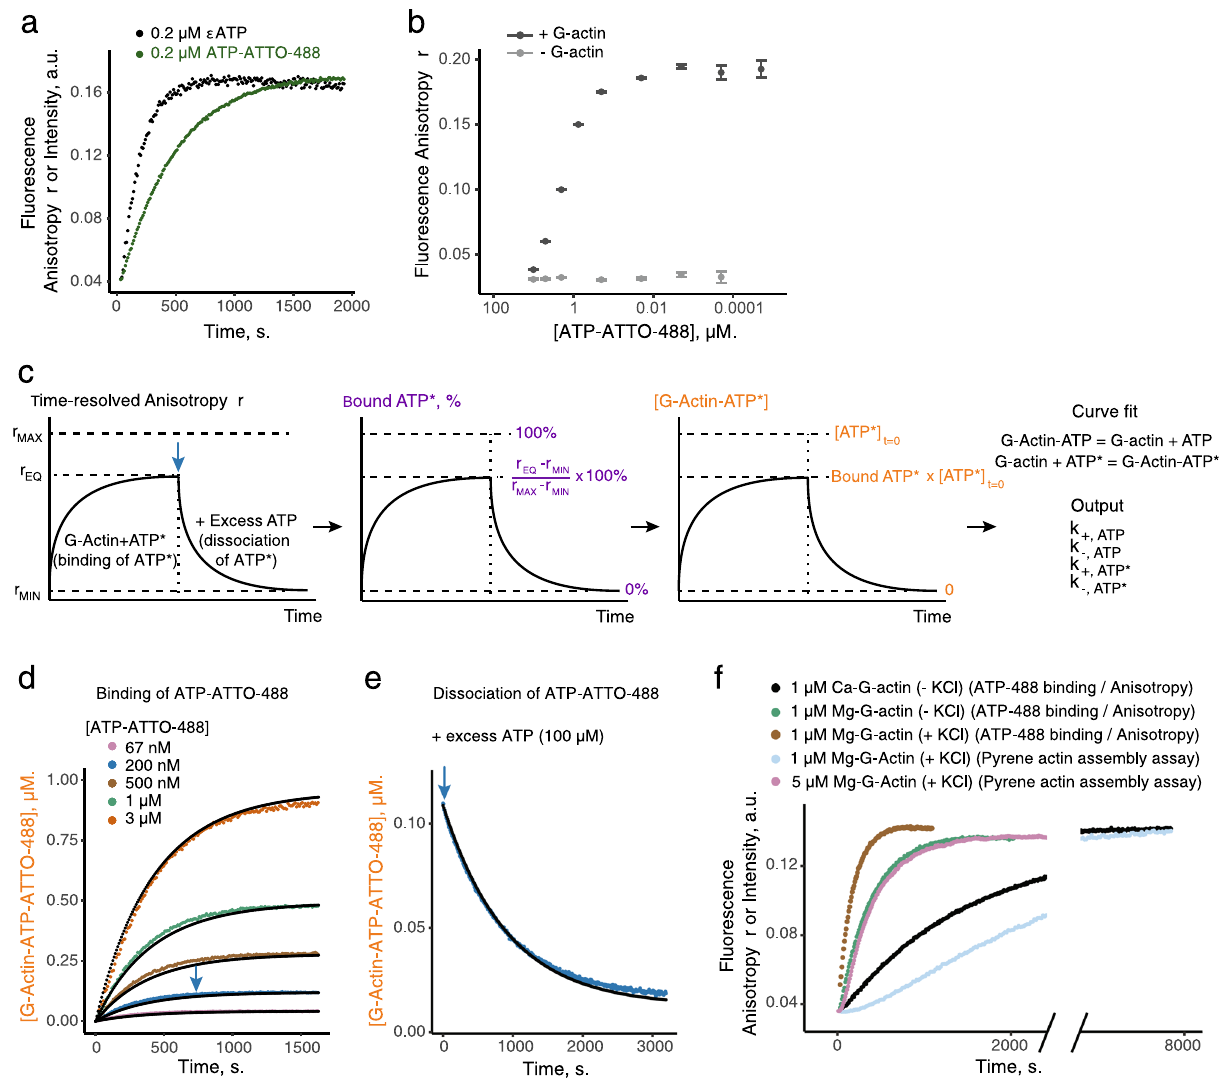
Fig. 2 A methodology for characterizing the binding kinetics of ATP-ATTO-488 to monomeric actin (G-actin) by fl uorescence anisotropy. ATP adenosine triphosphate, ε ATP N 6 -etheno-ATP, r MIN free ATP-ATTO-488 anisotropy value, r MAX ATP-ATTO-488 anisotropy value when bound to G-actin, r fl uorescent ATP. a Comparison of the binding kinetics of ε ATP (0.2 µ M; black curve) or EQ ATP-ATTO-488 anisotropy value at equilibrium, ATP* is for ATP-ATTO-488 (0.2 µ M; green curve) to G-actin (2 µ M) in NFG + MEI buffer. For ε ATP, time course of nucleotide exchange was followed by recording the fl uorescence signal over time at 10 s time-intervals. For ATP-ATTO-488, time course of nucleotide exchange was followed by measuring changes in the anisotropy value r over time every 10 s. Please note that at plateau the values of the ε ATP curve decreases due to photobleaching. b Sensitivity of the method, evaluated by measuring average steady-state anisotropy values (measured 30 min after initiation of the experiment in NFG + MEI buffer) and standard deviations after exchange of variable concentrations of ATP-ATTO-488 on G-actin (2 µ M) indicate that binding to G-actin can be precisely detected down to 20 pM of ATP-ATTO-488. Light (resp. dark) gray represent conditions in the absence (resp. presence) of G-actin. n = 20 for each condition. c Cartoon representing how kinetic data obtained from ATP* binding or dissociation curves were used to obtain the association and dissociation rates of ATP and ATP* to G-actin. Blue arrow represents the moment when an excess of ATP is added to dissociate ATP*. Y axis colors indicate conversions of anisotropy values (black) into ATP* binding percentage (purple) and concentration of G-actin bound to ATP* (orange). d Binding kinetics (colored data) and fi t curves (black) in the presence G-actin (2 µ M) and increasing concentration of ATP-ATTO 488 in NFG + MEI buffer. Blue arrow indicates the time when an excess of ATP was added in e . e Kinetics (blue data from the 200-nM ATP-ATTO-488 condition of d ) and fi t curve (black) of ATP-ATTO-488 dissociation from G-actin in the presence of an excess of ATP (100 µ M) in NFG + MEI buffer. d , e were fi tted with the same kinetic parameters: k + ,ATP = 10 µ M − 1 s − 1 ; k + ,ATP-ATTO-488 = 12 µ M − 1 s − 1 ; k − ,ATP = 2.8 × 10 − 3 s − 1 ; k − ,ATP-ATTO-488 = 10 − 3 s − 1 . f Effect of bound divalent cation (Ca 2 + ; in NFG buffer, black curve; 5-fold slower than with Mg 2 + , green curve) and salt (50 mM KCl; in NFG + KMEI buffer, brown curve; 2-fold faster than without KCl) on the binding kinetics of ATP-ATTO-488 (0.2 µ M) to G-actin (1 µ M). Blue and pink curves are from pyrene-actin assembly assay in NFG + KMEI buffer, normalized to their plateau values, to demonstrate that ATP-ATTO-488 exchange kinetics in the presence of 50 mM KCl can be determined at low concentrations of G-actin for which actin assembly remains negligible at the time scale of nucleotide exchange. Source data are provided as a Source Data fi